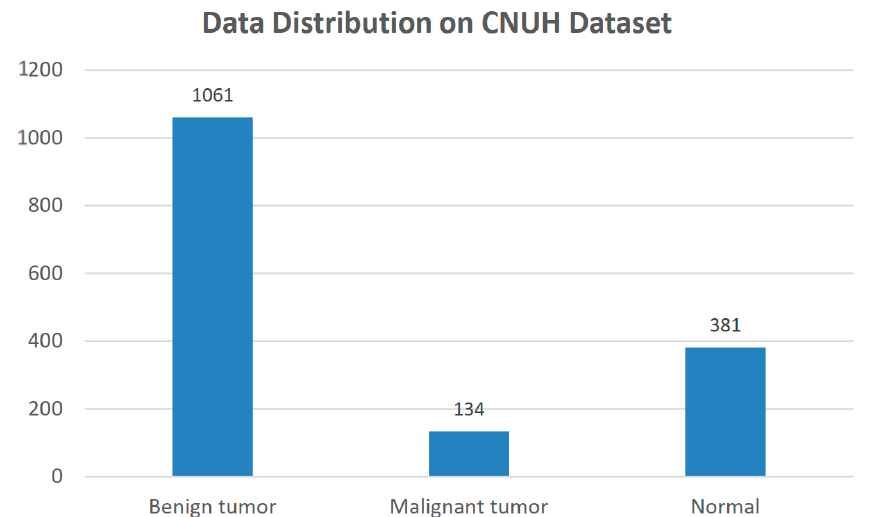
Figure 2. Sample images in the CNUH Dataset.